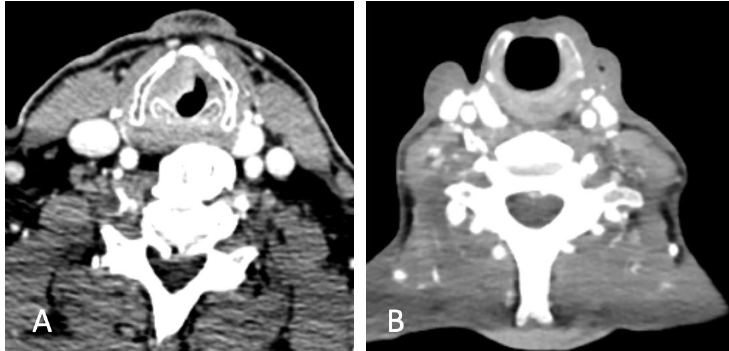
Figure 1. ( A ) CT scan of laryngeal carcinoma of the left vocal fold. ( B ) Post-operative CT scan of new laryngeal anatomy.